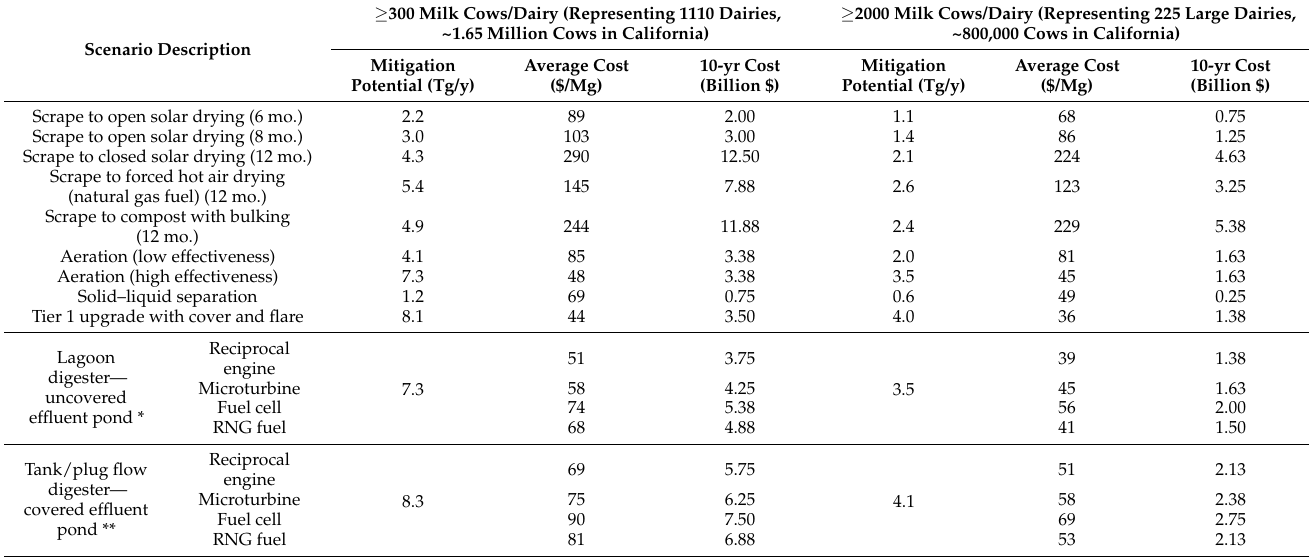
Table 4. Scenario summary: mitigation potential and 10-year cost